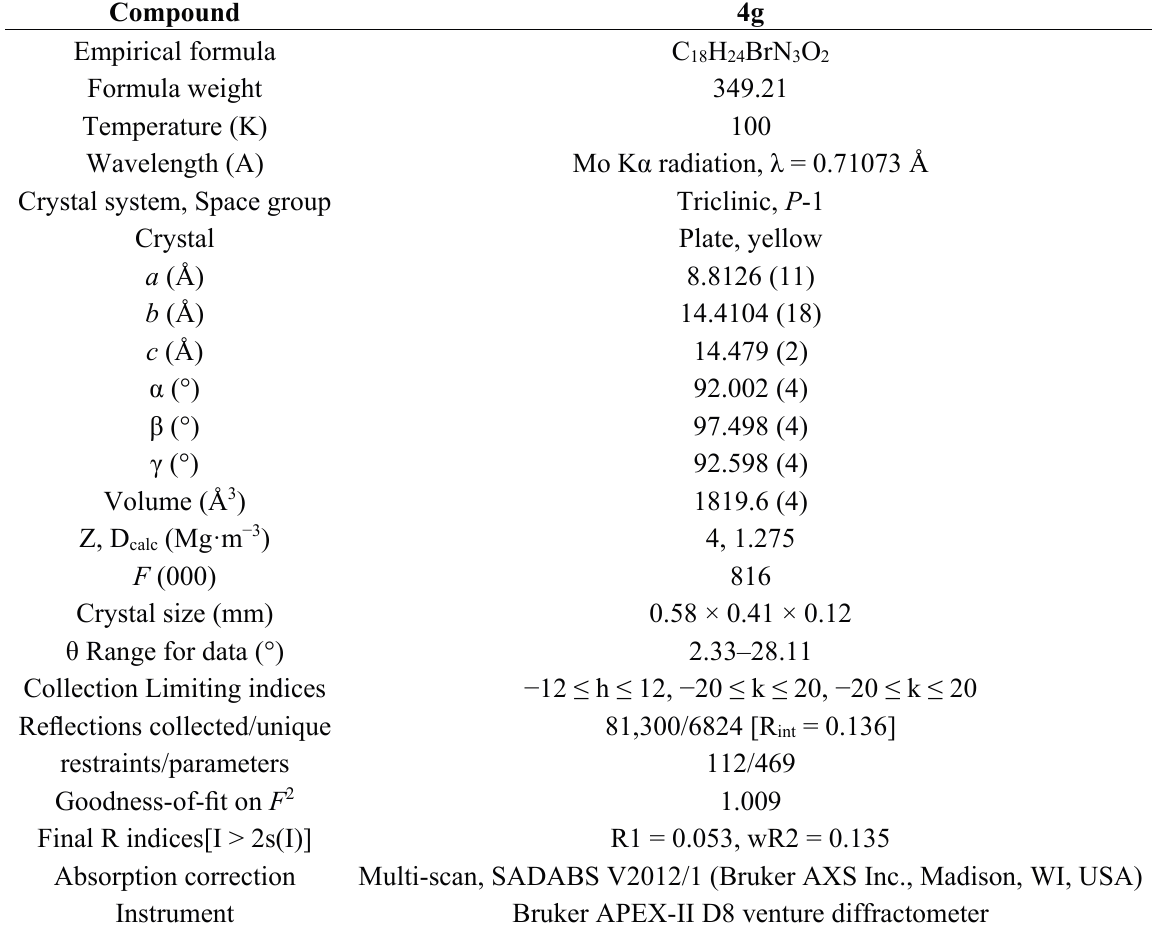
Figure 3. ORTEP diagram of the asymmetric unit consisting of two symmetry-independent molecules. The ellipsoids are drawn at the 50% probability level with hydrogen atoms being shown as spheres of arbitrary radii. One of the molecules has disorder in the side chain C11B—C13B. Table 1. Details of data collection and structure re fi nement for compound 4g